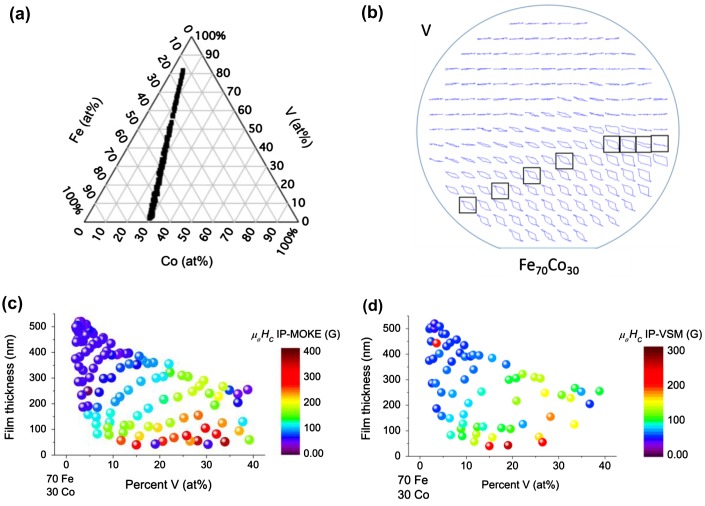
(a) Ternary composition diagram of the Fe70Co30-V natural thickness gradient from library UMD2. (b) Out-of-plane MOKE hysteresis loop map of the same natural thickness spread. Each MOKE hysteresis loop is positioned at its respective position on the wafer which is depicted with the wafer flat at bottom. The field range of each loop is 400 kA m–1 (5 kOe). Hysteresis loops of the nominal composition Fe65Co26V9 are boxed where decreasing film thickness goes from left to right. (c) In-plane MOKE coercive field (μ
0
H
C) map of thickness versus V composition where coercive field is color mapped. (d) In-plane VSM coercive field map with thickness versus V composition.